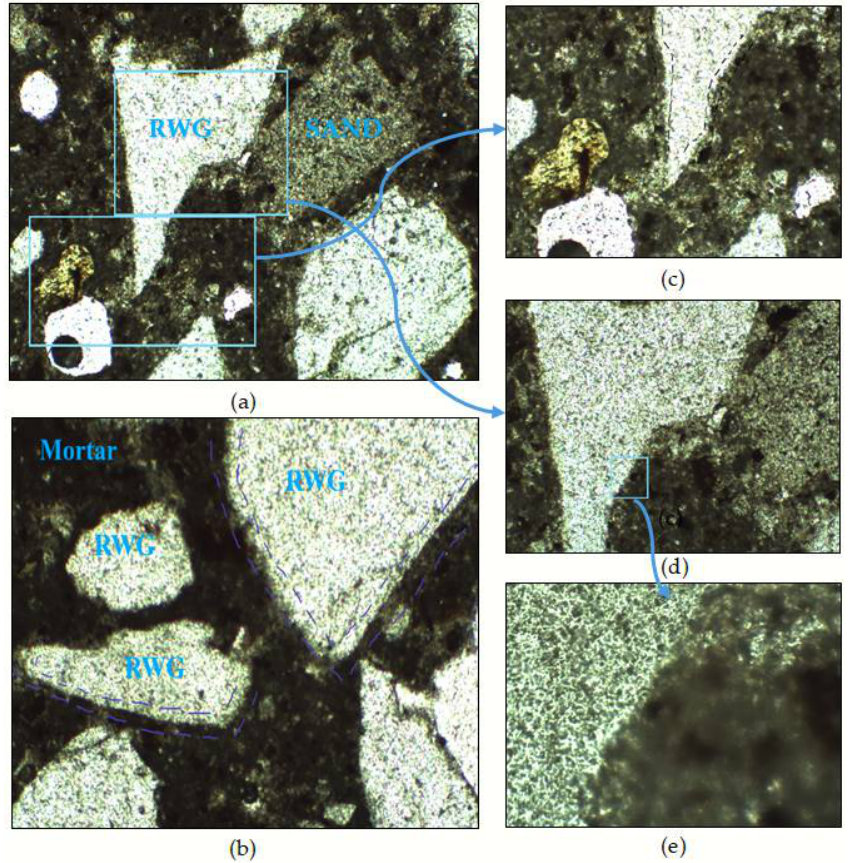
Figure 10. Optical macroscopic view of CRWG50 after 90 days of curing: ( a , b ) at magnification 100 × ; ( c , d ) at 200 × magnification; ( e ) at 500 × magnification.